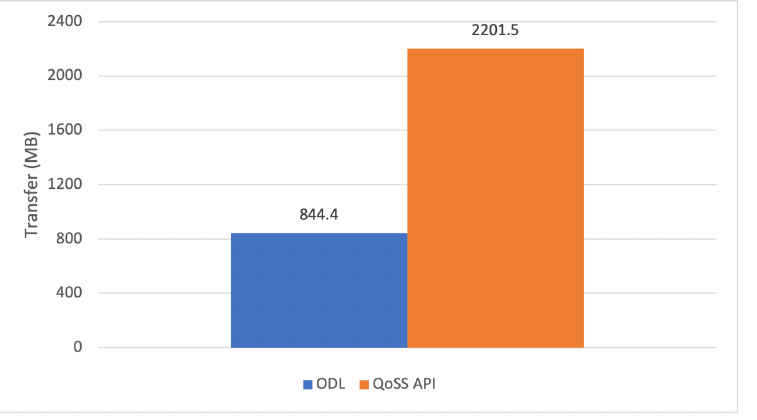
Figure 8. TCP Data transfer comparison. Controller default (ODL -SPF) vs. QoSS API (APP_RT). Time interval: 200 s.